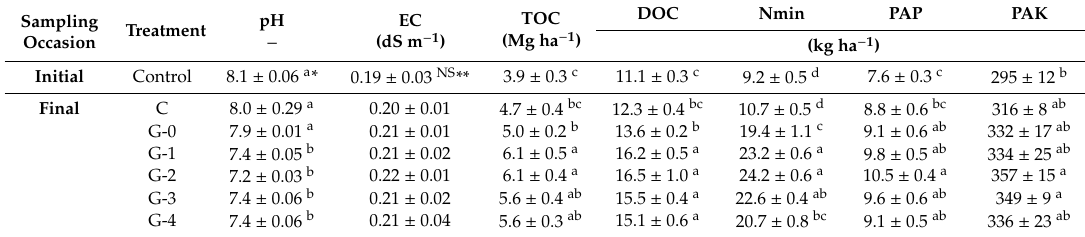
Table 3. Mean ± SE (n = 4) of initial (before treatment application) and final (after last harvest of spinach crop) soil characteristics, such as pH, electrical conductivity (EC), total organic carbon (TOC), dissolved organic carbon (DOC), mineral N (Nmin), plant available phosphorous (PAP) and potassium (PAK) of di ff erent